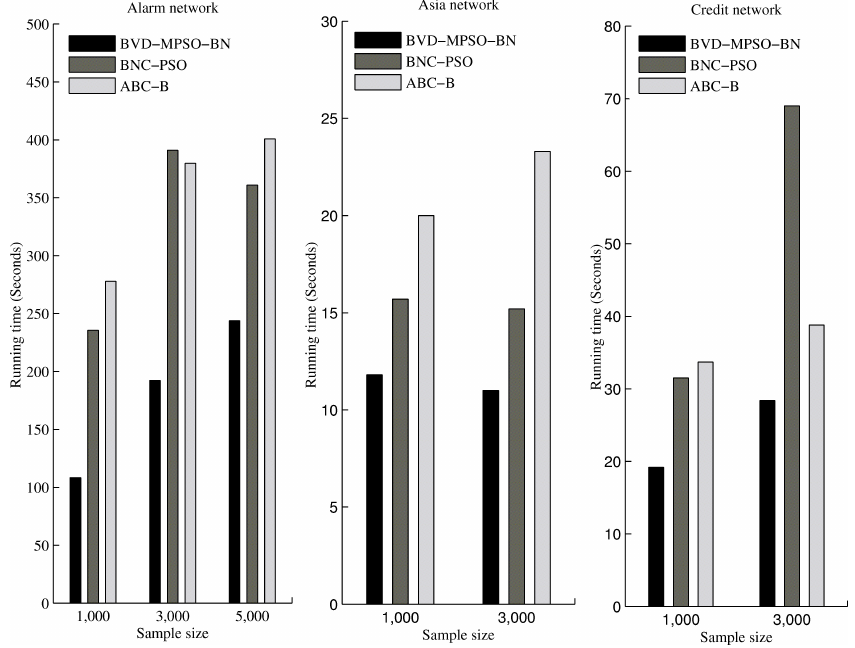
Fig. 2. Time performance on three different